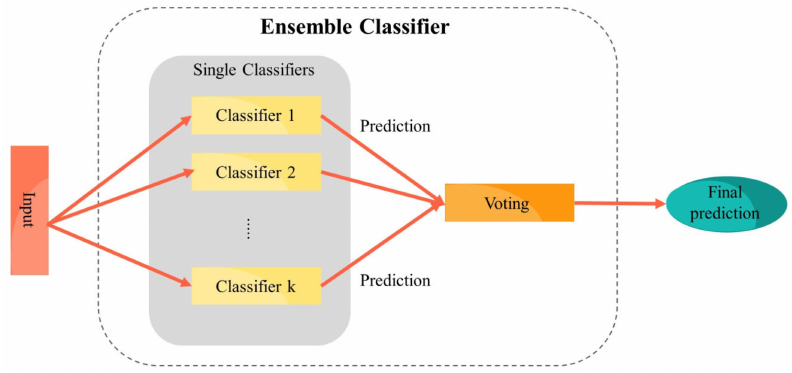
Figure 2. Framework of ensemble